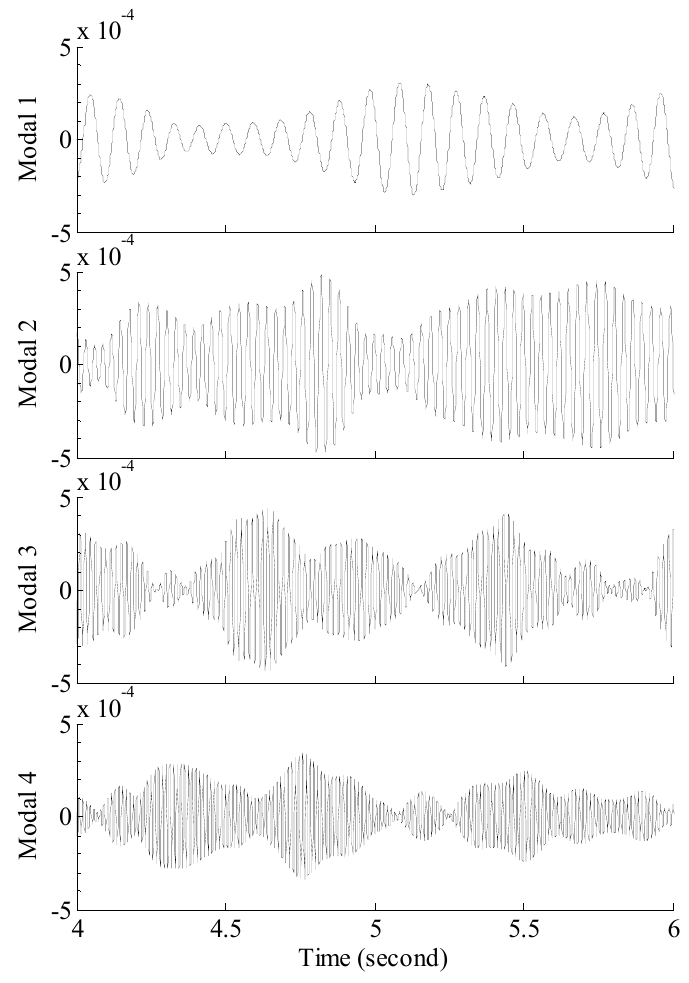
Figure 5. Modal responses of the strain gauge measurement data obtained by EMD method with intermittency criteria. Model 1: modal response for the 1st mode; Model 2: modal response for the 2nd mode; Model 3: modal response for the 3rd mode; Model 4: modal response for the 4th mode.